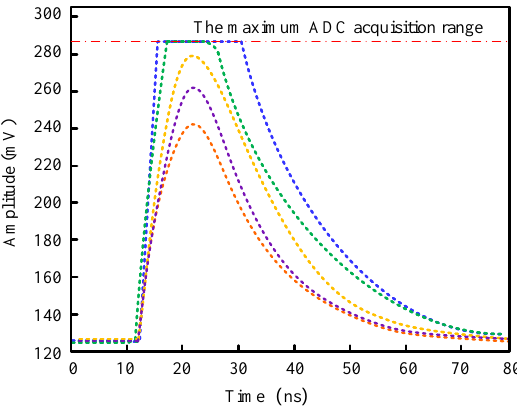
Figure 8. The top of the pulse is cut off when the pulse exceeds the maximum dynamic range of the ADC.